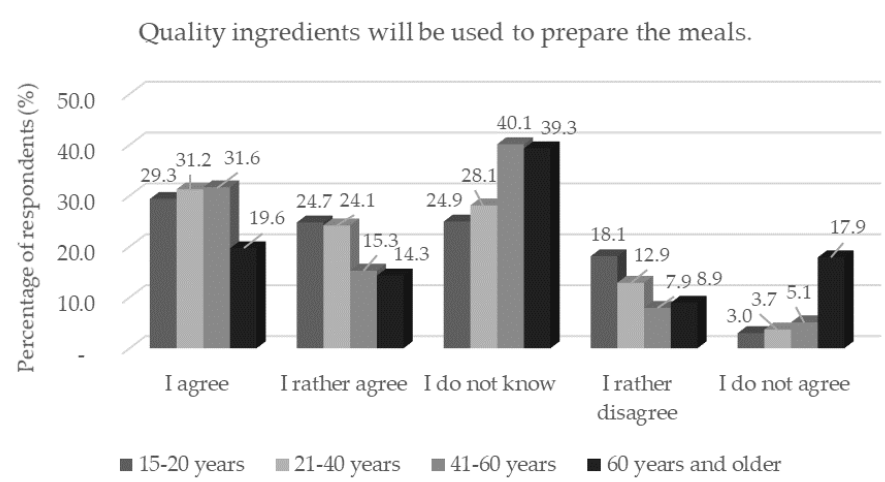
Figure 4. Respondents’ worries and understandings ( n = 1156) by age category in response to the statement: “Quality ingredients will be used to prepare the meals.”. Table 3. Three-Dimensional Food Printing, Worries and Understanding. Distribution of respondents